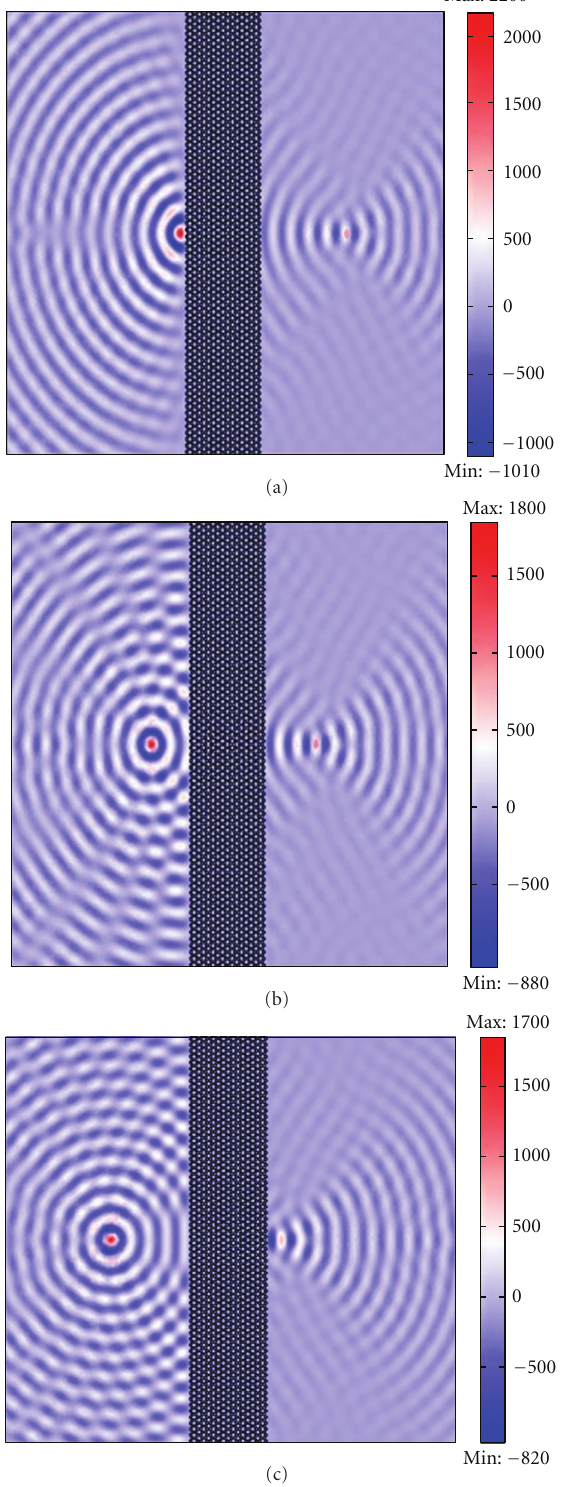
Figure 9: Imaging of a point source by a slab of 2D PhC of hexagonal lattice. The interface is normal to the Γ -M direction, and the normalized frequency is ω = 0 . 315(2 πc /a ). The distance between the source and the first interface is d 1 , the distance between the image and the second interface is d 2 , and the thickness of the √ 3 a . (a) d 1 < d/ 2, (b) d 1 = d/ 2, (c) d 1 > d/ 2. slab is d = 8 ×